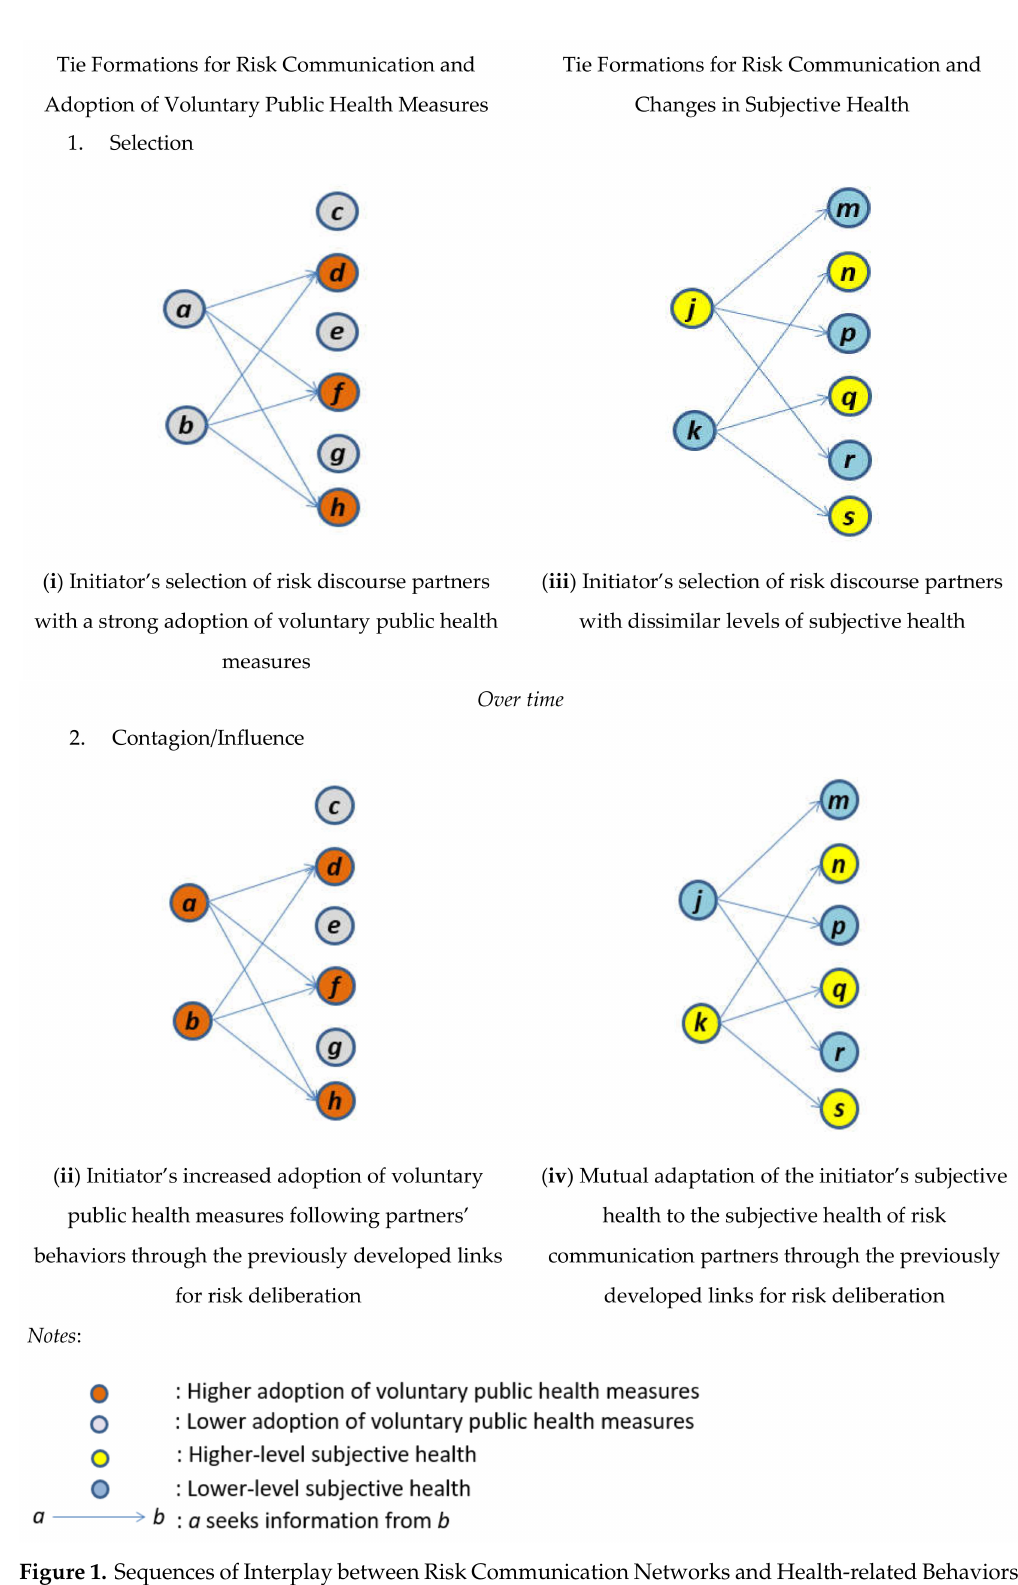
Figure 1. Sequences of Interplay between Risk Communication Networks and Health-related Behaviors over